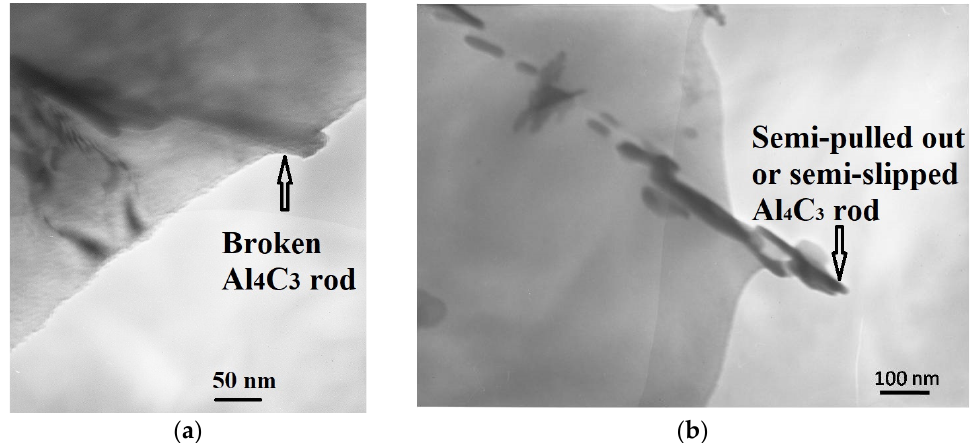
Figure 6. Fracture behavior of a composite with chemical bonding: ( a ) GNPs and A 4 C 3 fracture, ( b ) semi-pulled out or semi-slipped Al 4 C 3 from the matrix. The observed section is at the specimen's neck and in the direction of the tensile force.